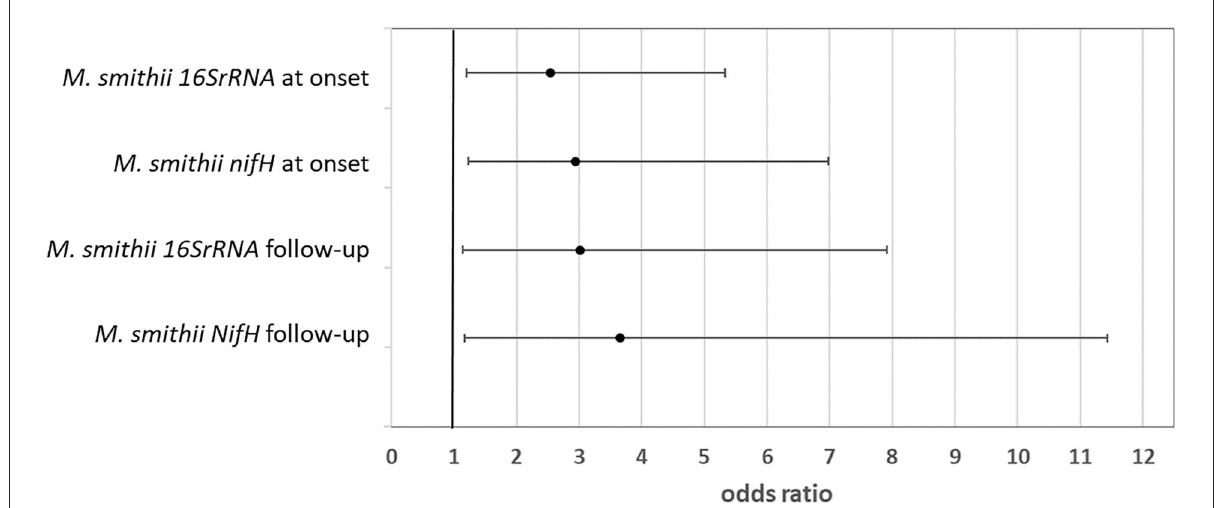
FIGURE2 Likelihood of severe outcome after the diagnosis linked to a higher amount of Methanobrevibacter smithii in the patient stool at both the onset and follow-up (odds ratio and 95% CI).